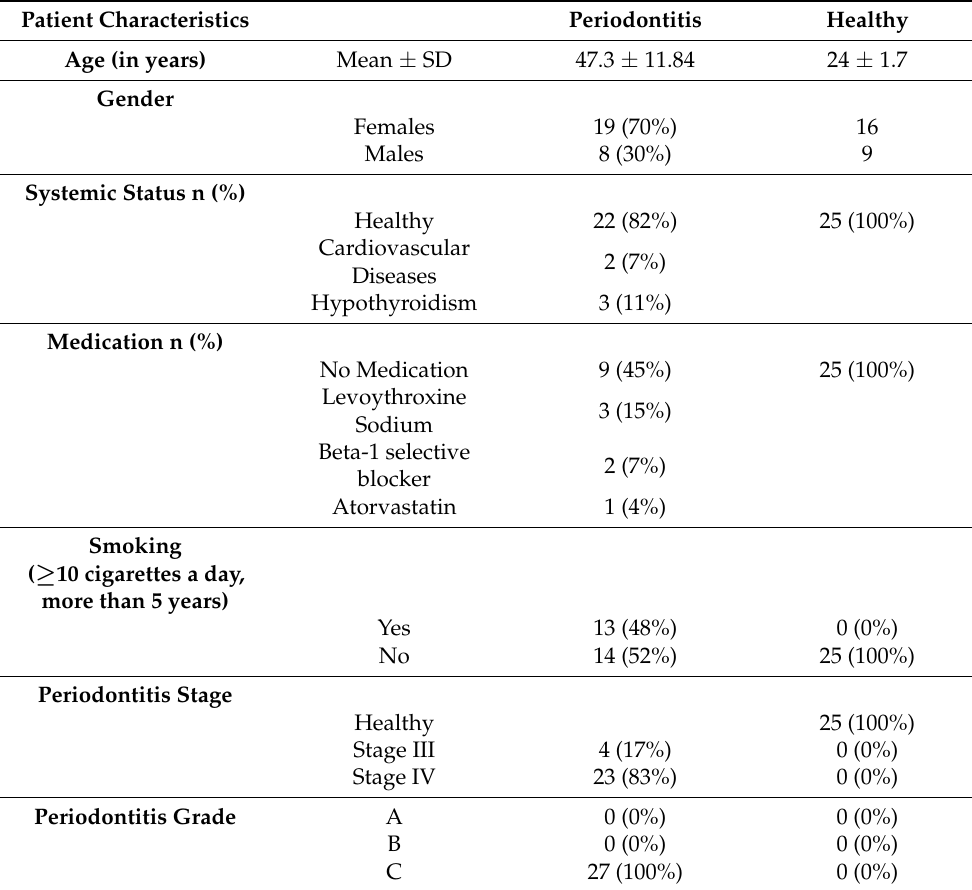
Table 1. General characteristics and periodontal classifications of study groups. Patient